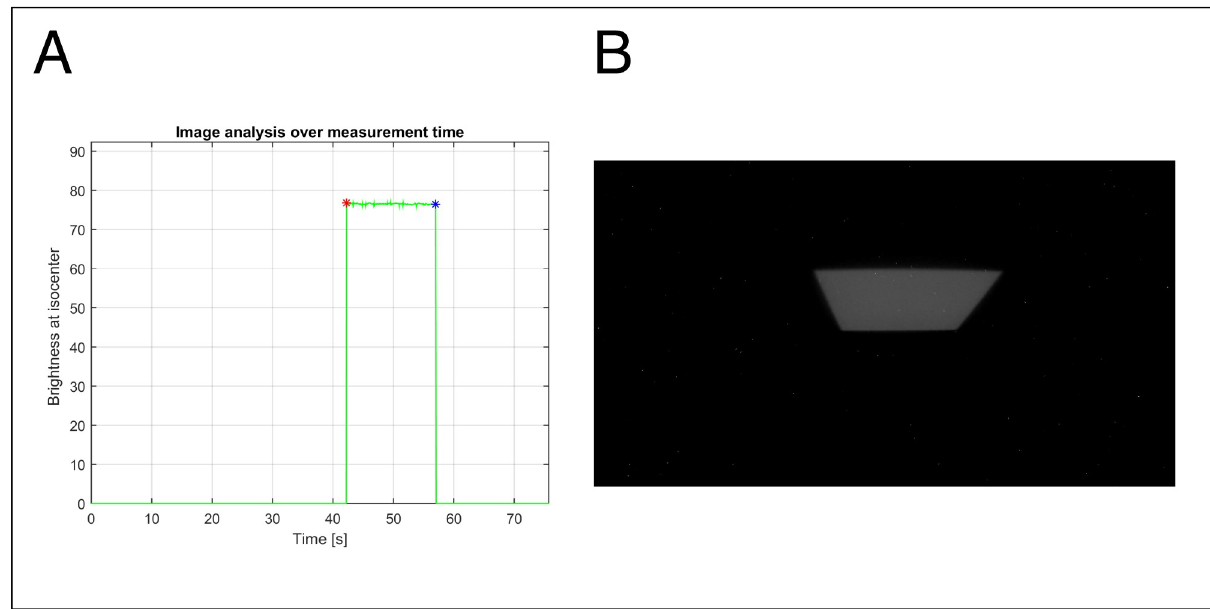
Fig 3. Analysis of the recorded scintillation distribution: (A) Signal of scintillation over time, recorded by the developed system. (B) Two-dimensional scintillation distribution captured by the HERO5 Black at 50.41 s.